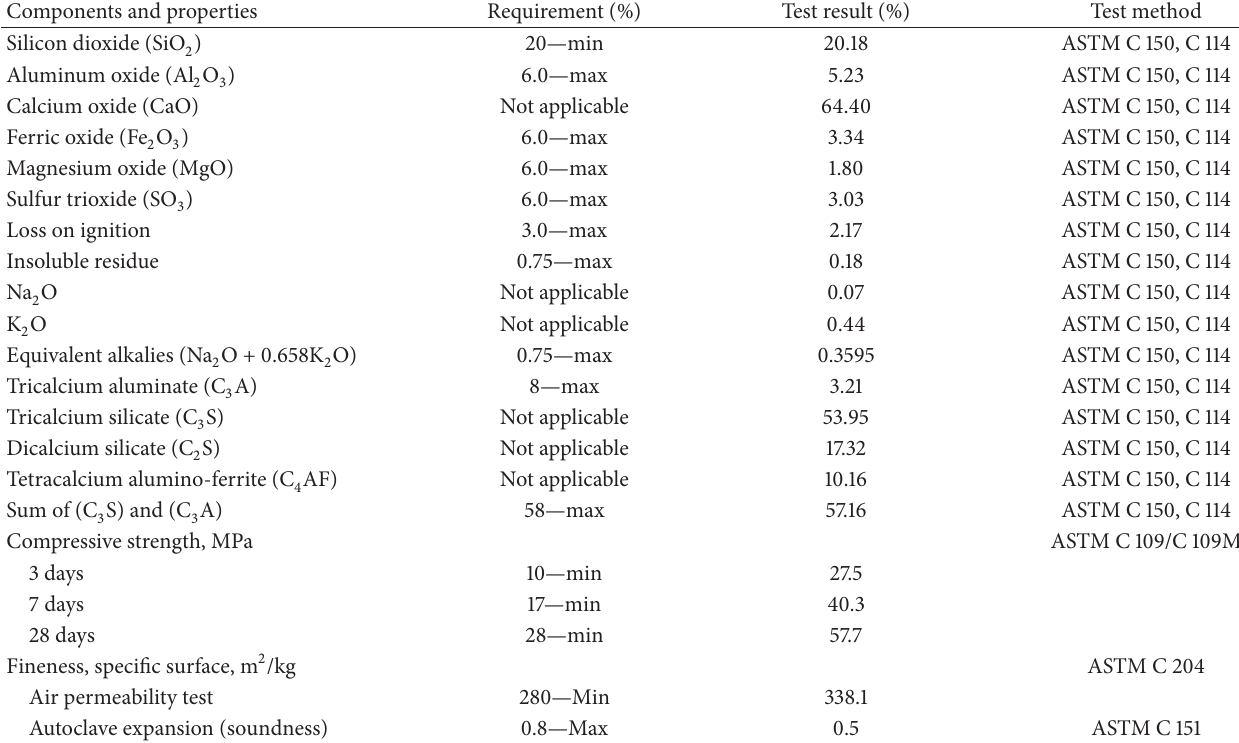
Table 2: Properties of Type II Portland